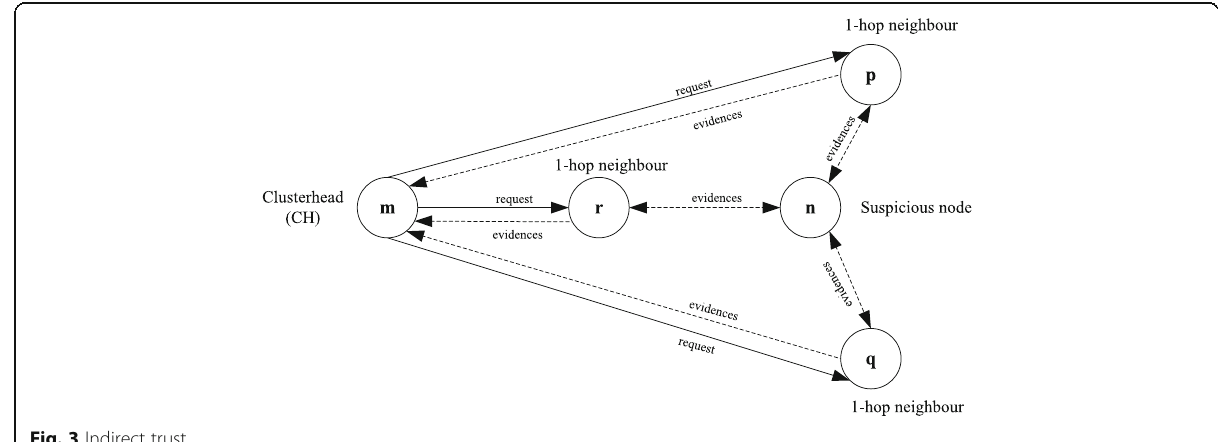
Fig. 3: indirect misbehaviour verification. The recom- mendations called evidences received from the cluster of x .The DS theory is used in practice with